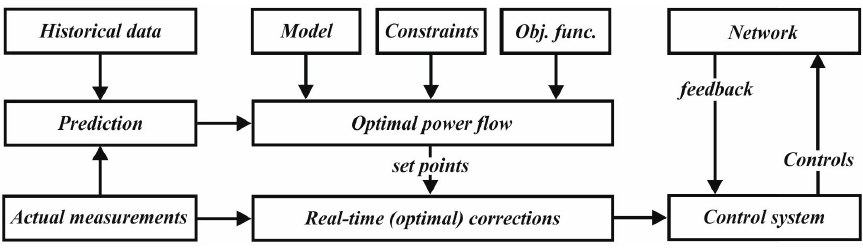
Figure 2. Illustration of a general RT-OPF method.